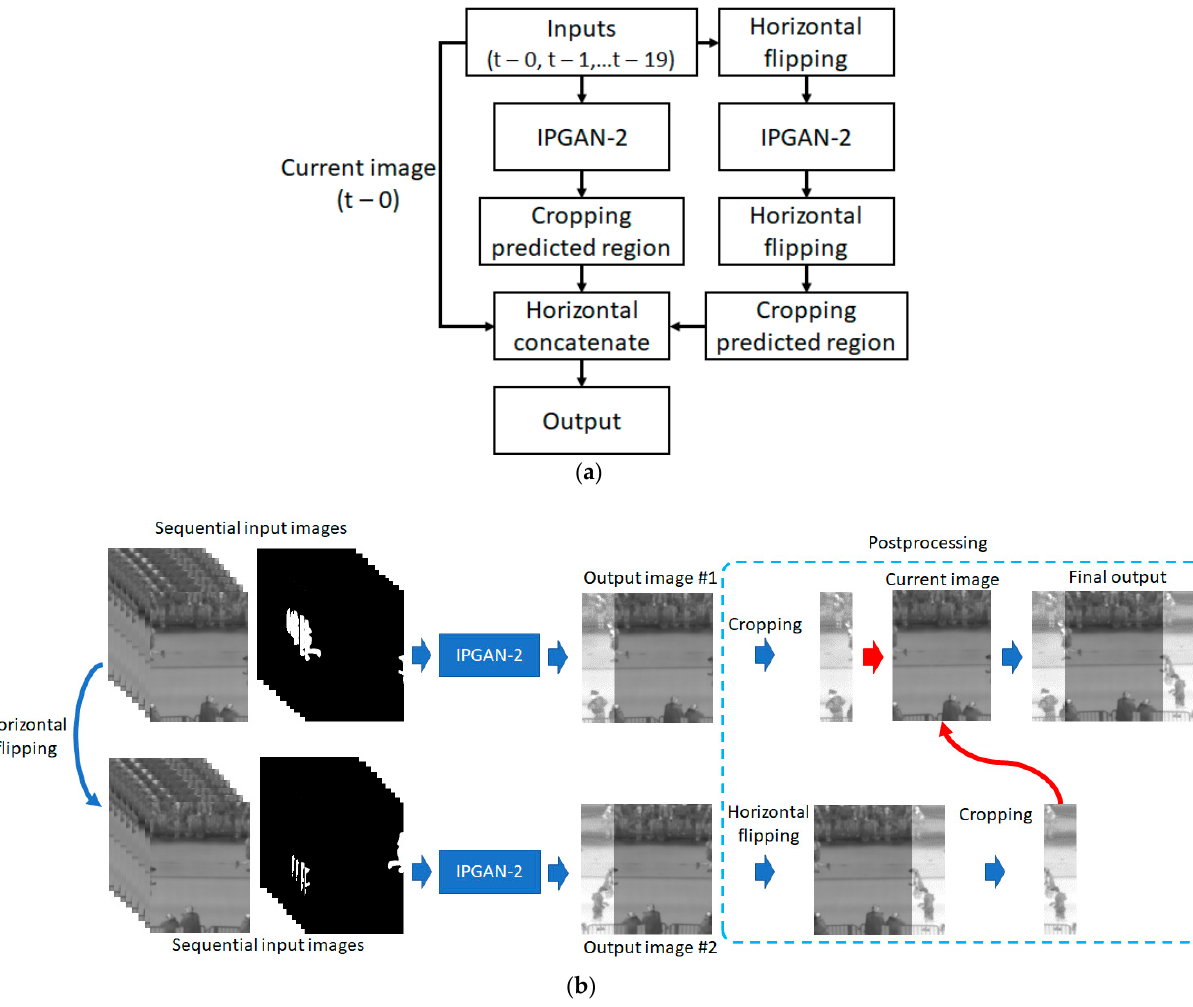
Figure 2. Flowchart of the proposed method. ( a ) Overall flowchart; ( b ) overall procedure with image examples. Table 2. The proposed method detailed by using pseudo code.